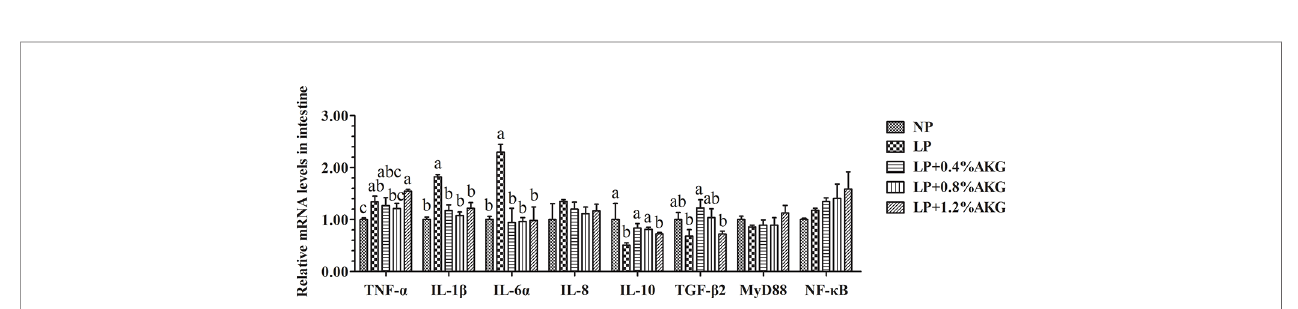
FIGURE 2 | Antioxidant capacity in the intestine of common carp ( Cyprinus carpio ) fed with diets containing normal protein (NP), low protein (LP), and different concentrations of alpha-ketoglutarate (AKG) after 8 weeks. (A) T-SOD, total superoxide dismutase (U/mg·prot); (B) CAT, catalase (U/mg·prot); (C) GSH-Px, glutathione peroxidase (mg/g·prot); (D) MDA, malondialdehyde (mmol/mg·prot); (E) Relative expressions of antioxidant-related genes via Nrf2/Keap1 signaling pathway. Antioxidant-related genes includes catalase (CAT), copper, zinc superoxide dismutase (CuZnSOD), glutathione peroxidase 1a (GPx1a), glutathione peroxidase 1b (GPx1b), Kelch-like-ECH-associated protein 1 (Keap1) and NF-E2-related factor 2 (Nrf2). Values are expressed as the mean ± SEM (n = 4). Values marked with different letters indicate signi fi cant differences ( P < 0.05) between groups.